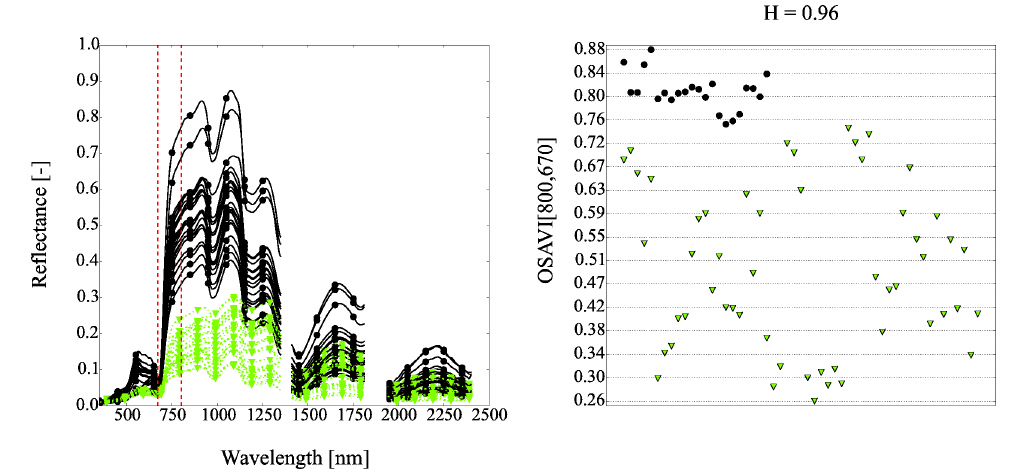
Figure 10. ( Left ) spectral signatures of SPHA (black) and AQ_A (green). Red dashed lines are Optimised Soil-Adjust Vegetation Index (OSAVI) [800,670] wavelengths; ( Right ) OSAVI [800,670] values for each vegetation type, H is the Hellinger distance.